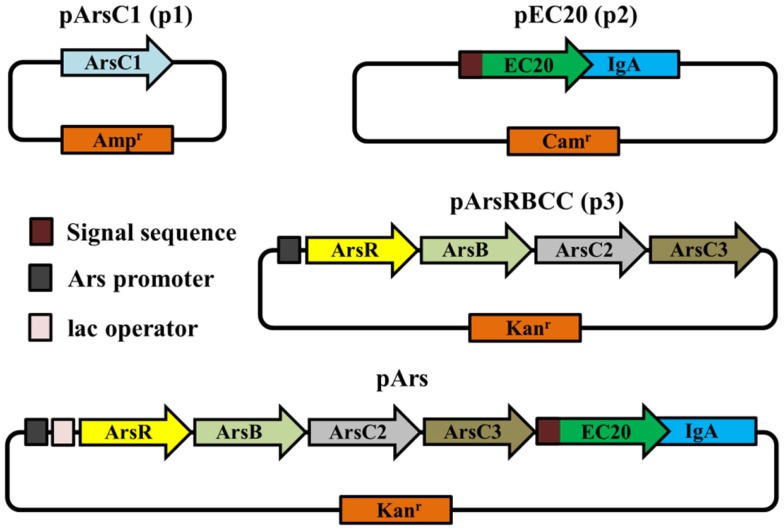
Schematic representations of vectors used in this study.